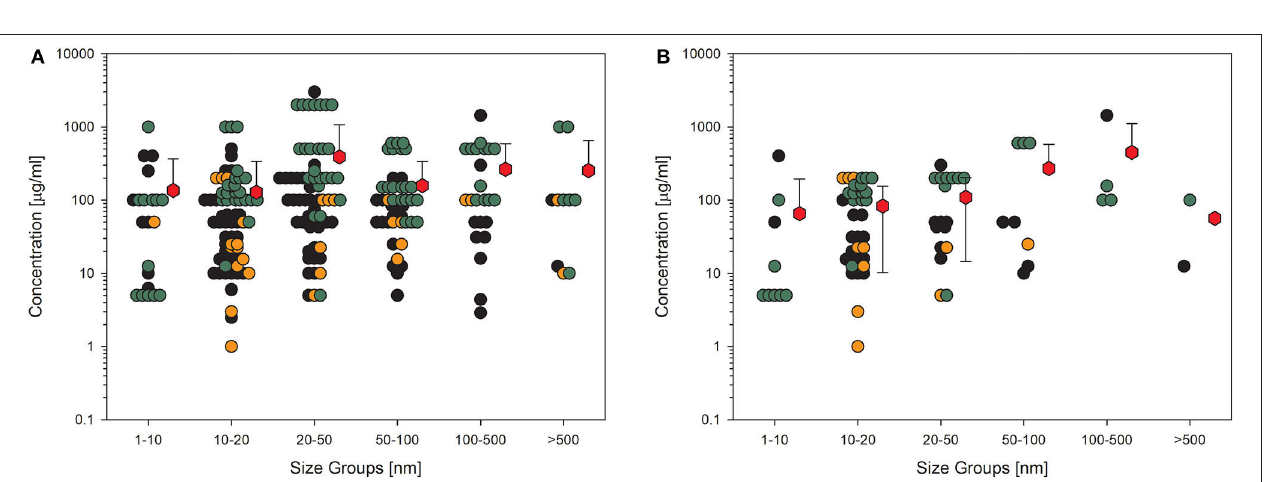
FIGURE 3 | Results of the evaluation of in vitro studies on disruption of the membrane integrity of cells treated with amorphous silica. Data have been collected in six size groups for primary particle size as indicated on the abscissa. (A) All available datasets; (B) datasets from studies with high-quality scores of 0.8 or 1. Details are as those shown in Figure 2 . Data points taken from the references are given in the Supplementary Material